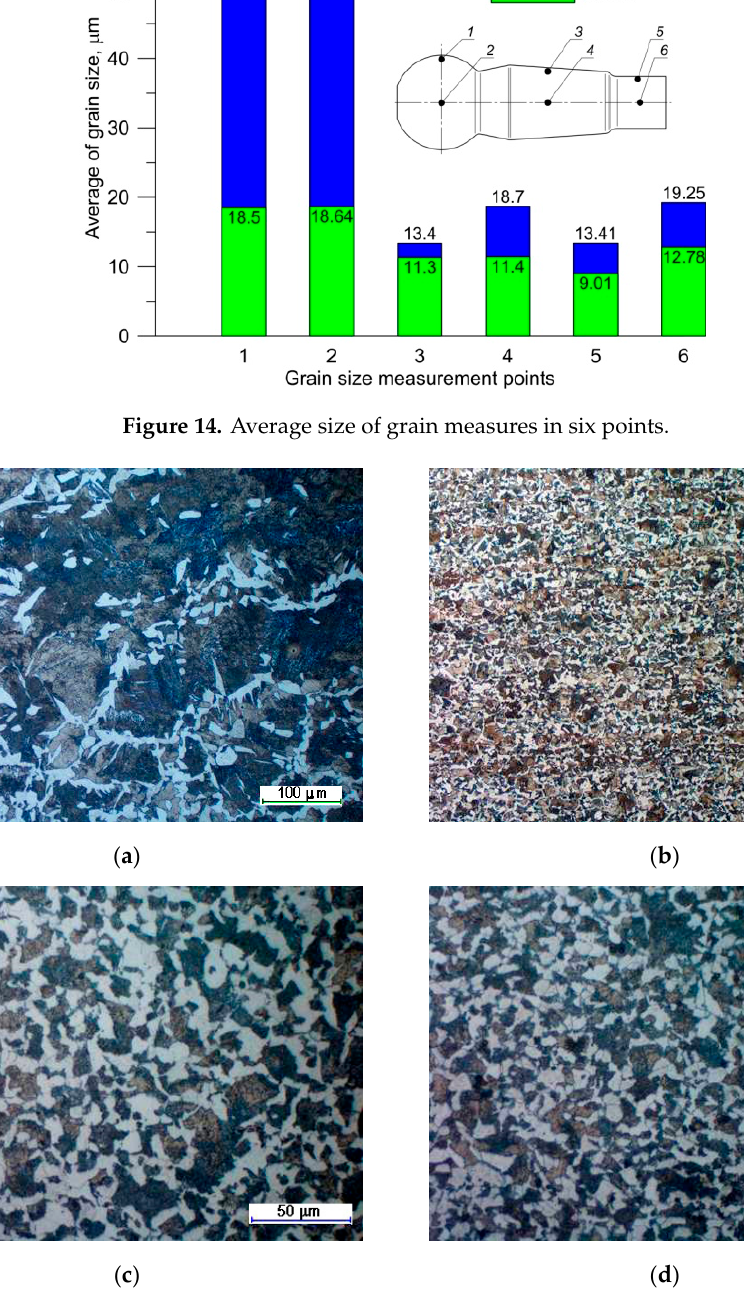
Figure 15. Exemplary photographs of the microstructure of the forgings manufactured using: ( a ) cross-wedge rolling (CWR) in point 2; ( b ) the helical-wedge rolling (HWR) method in point 2; ( c ) CWR in point 5; ( d ) HWR in point 5.